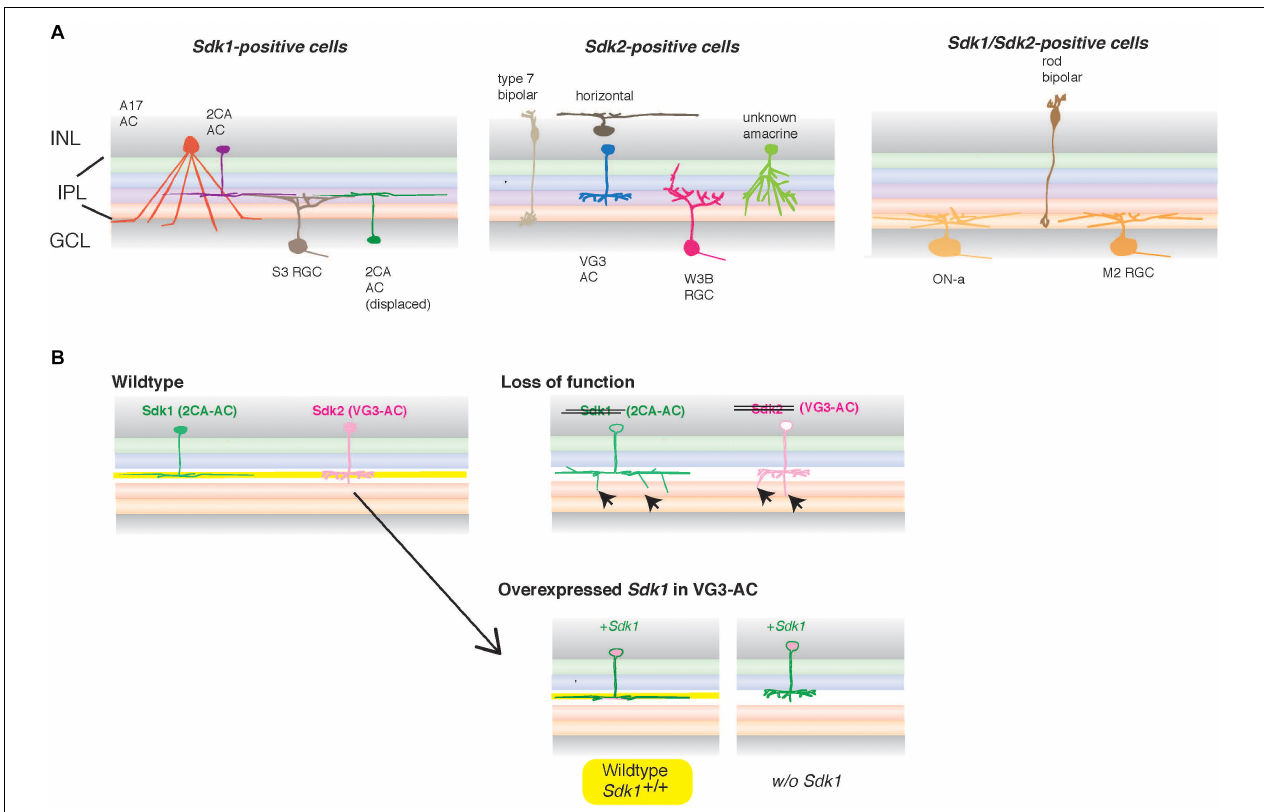
FIGURE 5 | Sdks in vertebrate retinal circuits. (A) In the inner plexiform layer (IPL), one of two synaptic layers in the retina, neurites of more than 50 types of interneurons (bipolar and amacrine cells) in the inner nuclear layer (INL) form synapses on dendrites of more than 40 types of retinal ganglion cells (RGCs) in the ganglion cell layer (GCL), thereby assembling the synaptic neuropil consisting of multiple sublaminae. In mice, Sdk1 and Sdk2 are expressed by distinct types of retinal neurons (adapted and modified from Yamagata and Sanes, 2019). Some RGC types as well as rod bipolar cells express both Sdk1 and Sdk2 (Right panel) (Krishnaswamy et al., 2015; Yamagata and Sanes, 2019). Sdk2 is expressed by restricted subsets of retinal neurons, including a non-canonical glutamatergic amacrine interneuron (AC) named VGlut3-positive (VG3) ACs and an RGC type called W3B. Sdk1 is not expressed by these Sdk2 -positive neurons but expressed by a subset of interneurons (type 2CA cells) and a unique Sdk1 + RGC. Those Sdk1 -expressing ACs (2CA) and RGC (S3 RGC) stratify narrowly in the same strata. Similarly, Sdk2 -expressing amacrine cells (VG3) and W3B-RGC arborize diffusely in the same IPL strata. (B) In the absence of Sdk1 , 2CA-ACs exhibit a reduced sublaminar restriction (arrows) (Yamagata and Sanes, 2019). Similarly, the deletion of Sdk2 leads to the reduced sublaminar restriction of VG3 arbors as well as dysfunction of this neural circuit with W3B-RGC (Krishnaswamy et al., 2015). Overexpression of Sdk1 in VG3 cells that normally express Sdk2 demonstrated that it plays an instructive role in sublaminar targeting in IPL and that it does so only in the presence of Sdk1 in the sublamina (shown in yellow), supporting the “IgSF code” hypothesis for laminar specificity during development. However, this Sdk1-mediated wiring cannot be changed once developed (Yamagata and Sanes, 2019), suggesting that the instructive role of Sdk1 is limited during